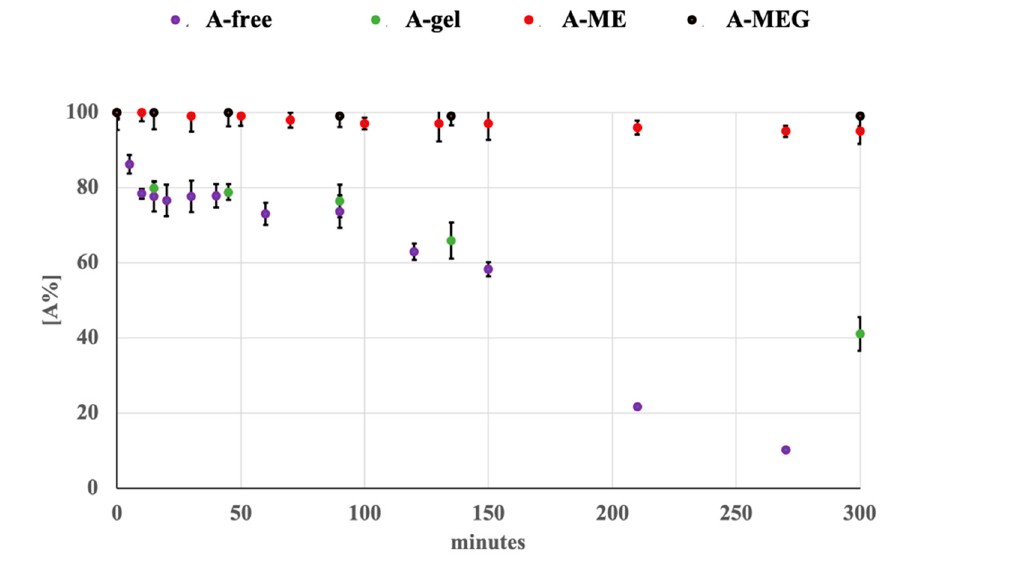
Figure 4. Photodegradation profiles of NA and A in all the tested formulations.